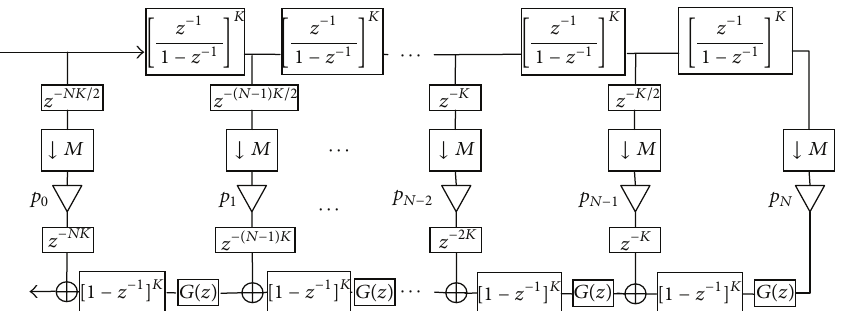
Figure 1: Proposed CIC-like structure for decimation filtering with sharpened compensated comb